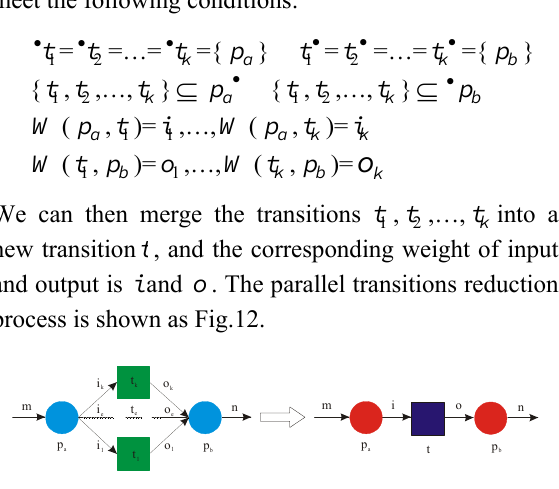
Fig.12. Parallel transitions reduction rule